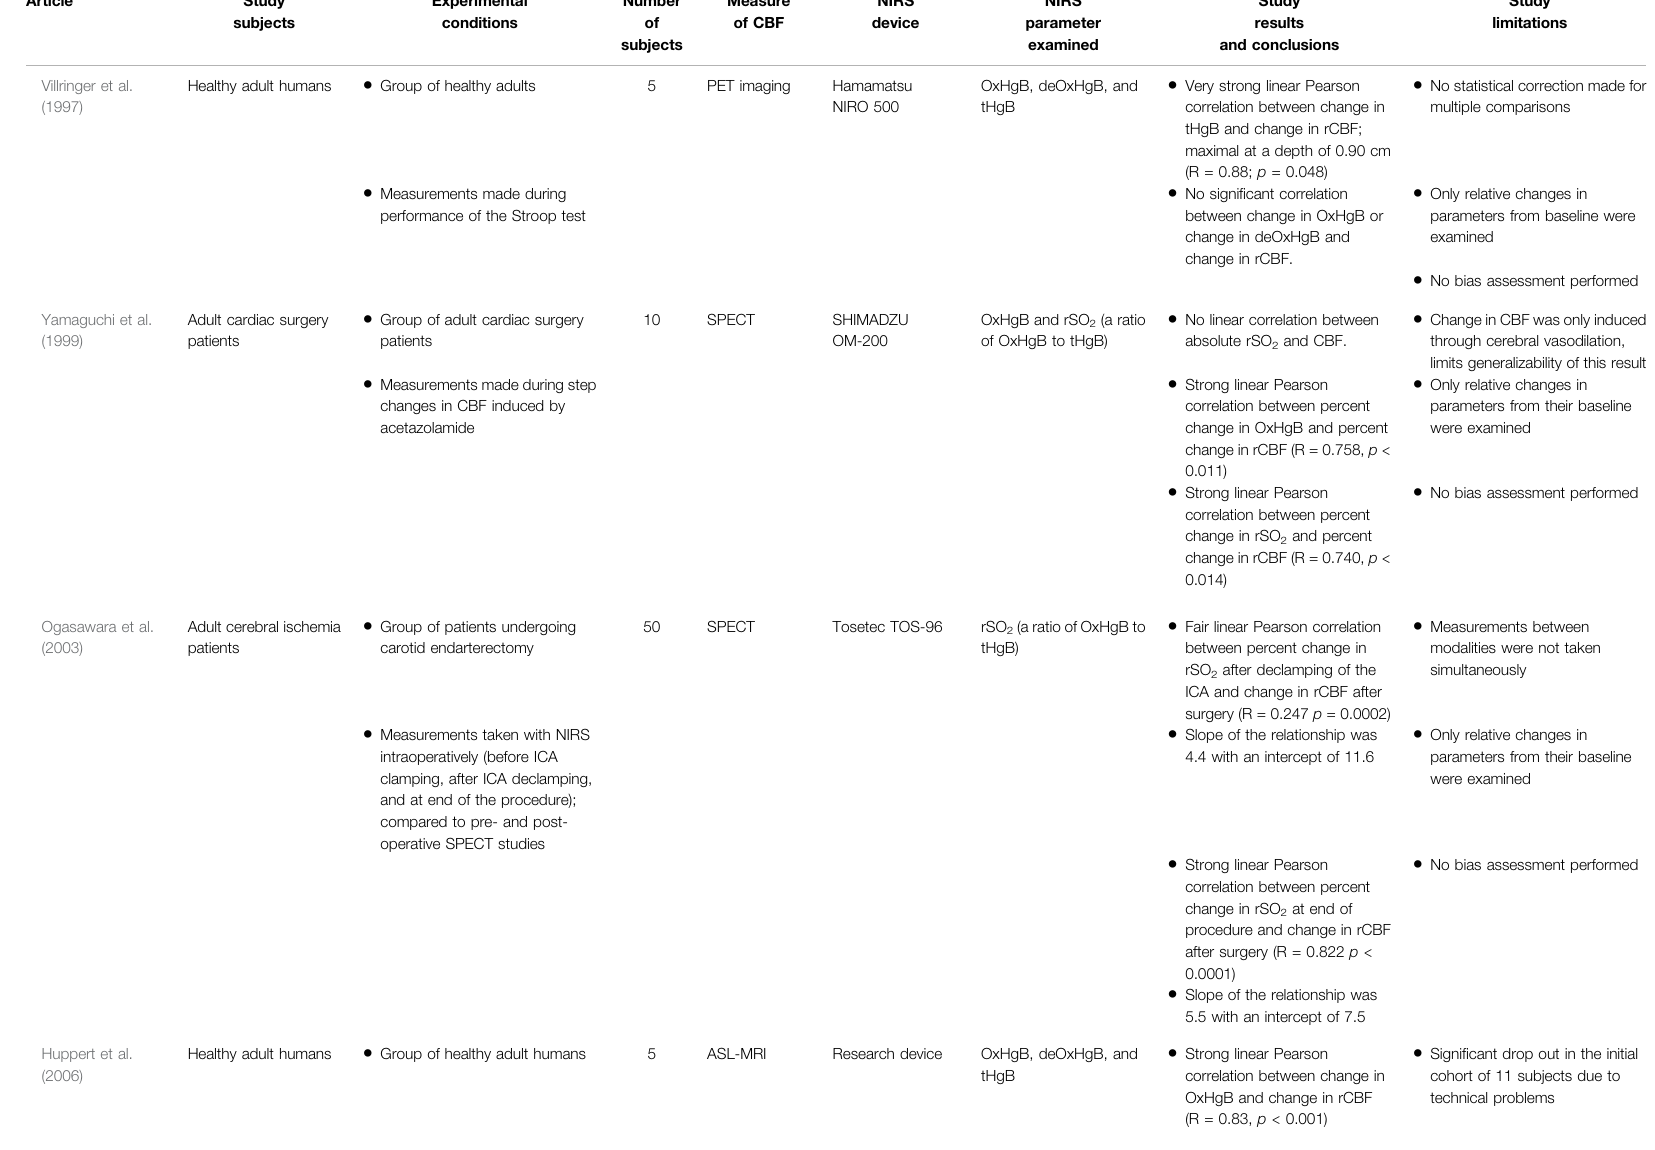
(cid:129) Strong linear Pearson correlation between change in OxHgB and change in rCBF (R = 0.83, p < 0.001)